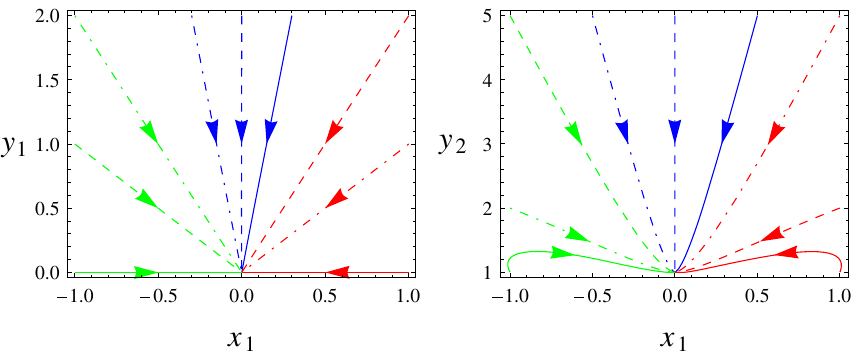
Fig. 1 Evolution of the three dimensionless parameters x 1 , y 1 and y 2 are shown in the ( x 1 , y 1 ) and ( x 1 , y 2 ) plane. In the left figure the system starts from (1, 0) (solid red), (1, 1) (red dotdashed), (1, 2) (red dashed), (0.3, 2) (solid blue), (0, 2) (blue dashed), ( − 0 . 3 , 2 ) (blue dotdashed) ( − 1 , 2 ) (green dotdashed), ( − 1 , 1 ) (green dashed) and ( − 1 , 0 ) (solid green) in the ( x 1 , y 1 ) plane and approaches the attractor solution (0, 0)